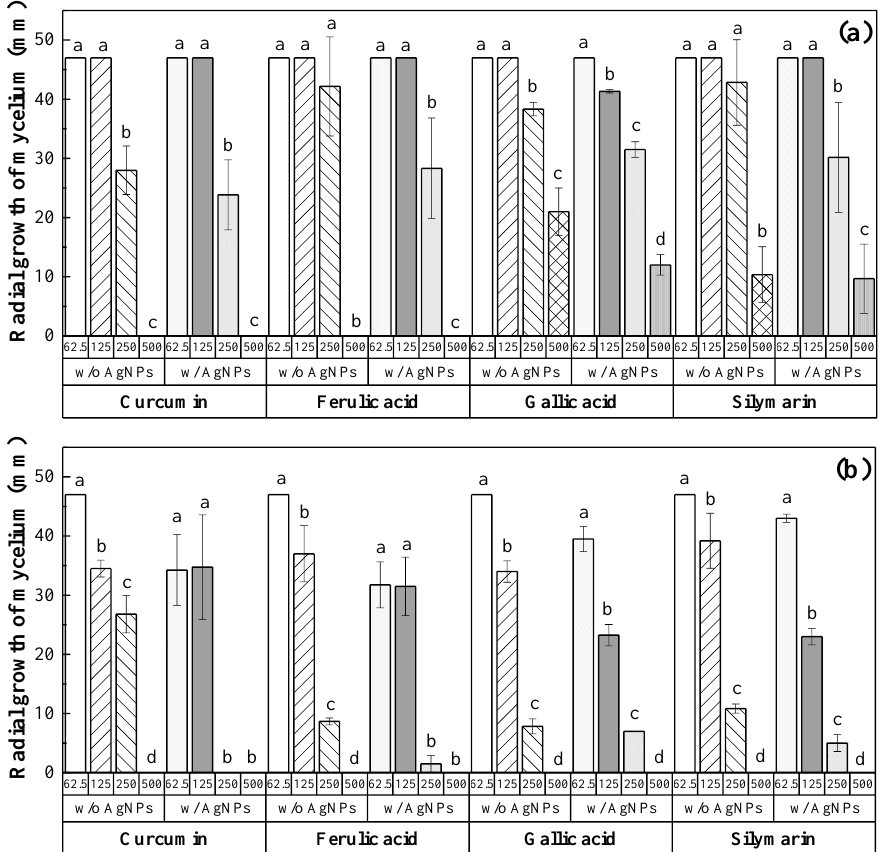
Figure 2. Radial growth values of F. culmorum in the presence of the composites, which consisted of different polyphenol inclusion compounds without (w/o) and with (w/) AgNPs at different concentrations of the composites (in µ g · mL − 1 ), either in a chitosan hydroalcoholic solution ( a ) or in a deep eutectic solvent ( b ) dispersion medium. A 47-mm radial growth was obtained for the control and the AgNPs-only treatments (not shown) in all cases. Concentrations labelled with the same lowercase letters are not significantly different at p < 0.05 by Tukey’s test. All values are presented as the average of three repetitions. Error bars represent the standard deviation across three replicates.